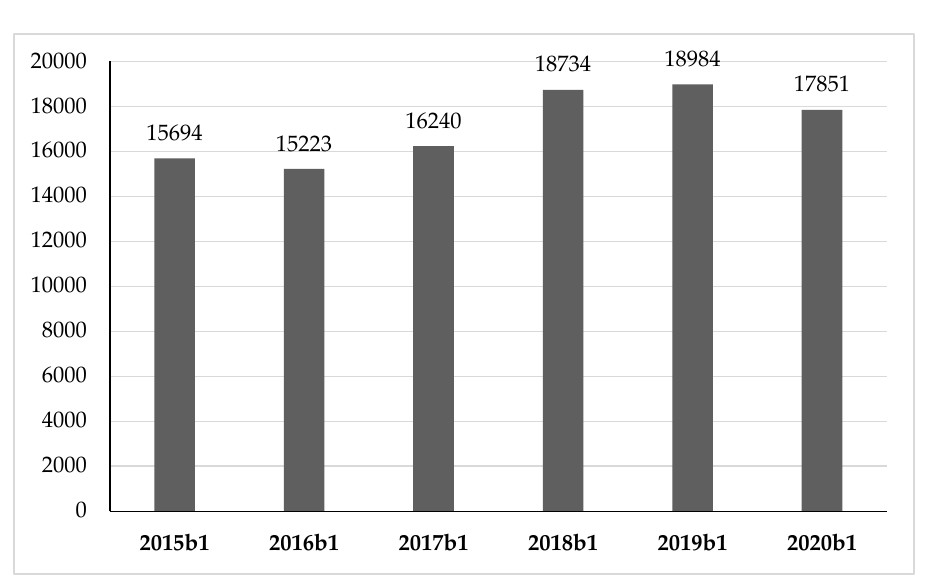
Table 6. Average price of wine in a 0.75 liter bottle (EUR/liter). 2015 b1